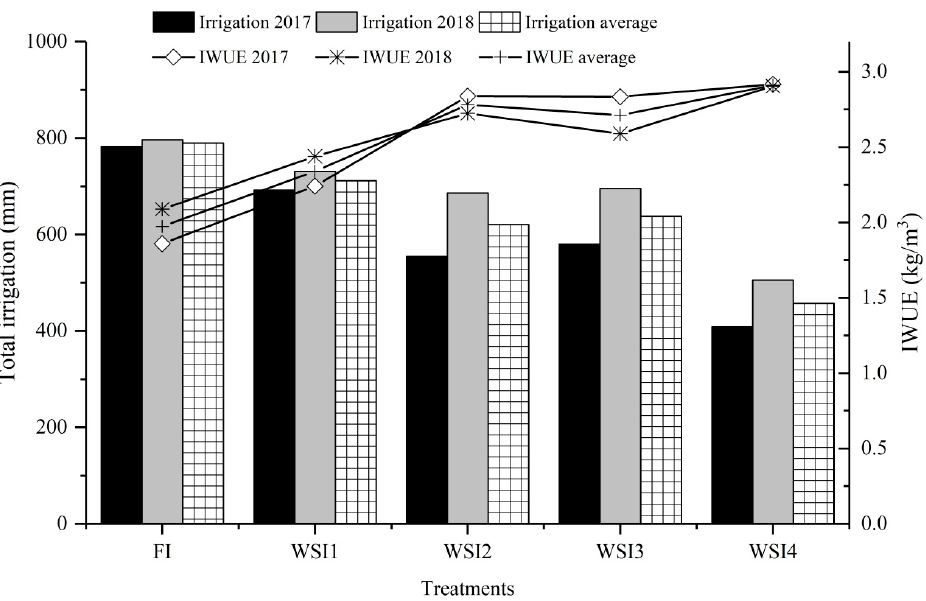
Figure 7. The total irrigation input and the irrigation water use efficiency of each treatment.